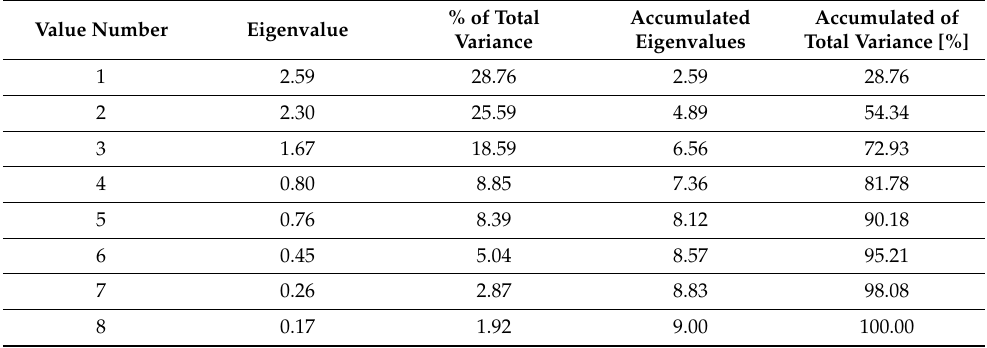
Table 2. The results of PCA main components analysis conducted for an additional variable repre- senting urbanization